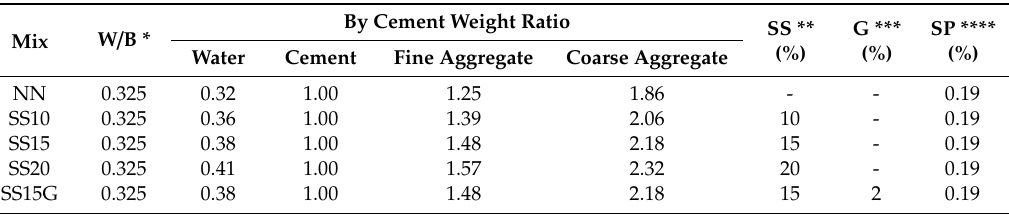
Table 1. Mix design of concrete specimens.